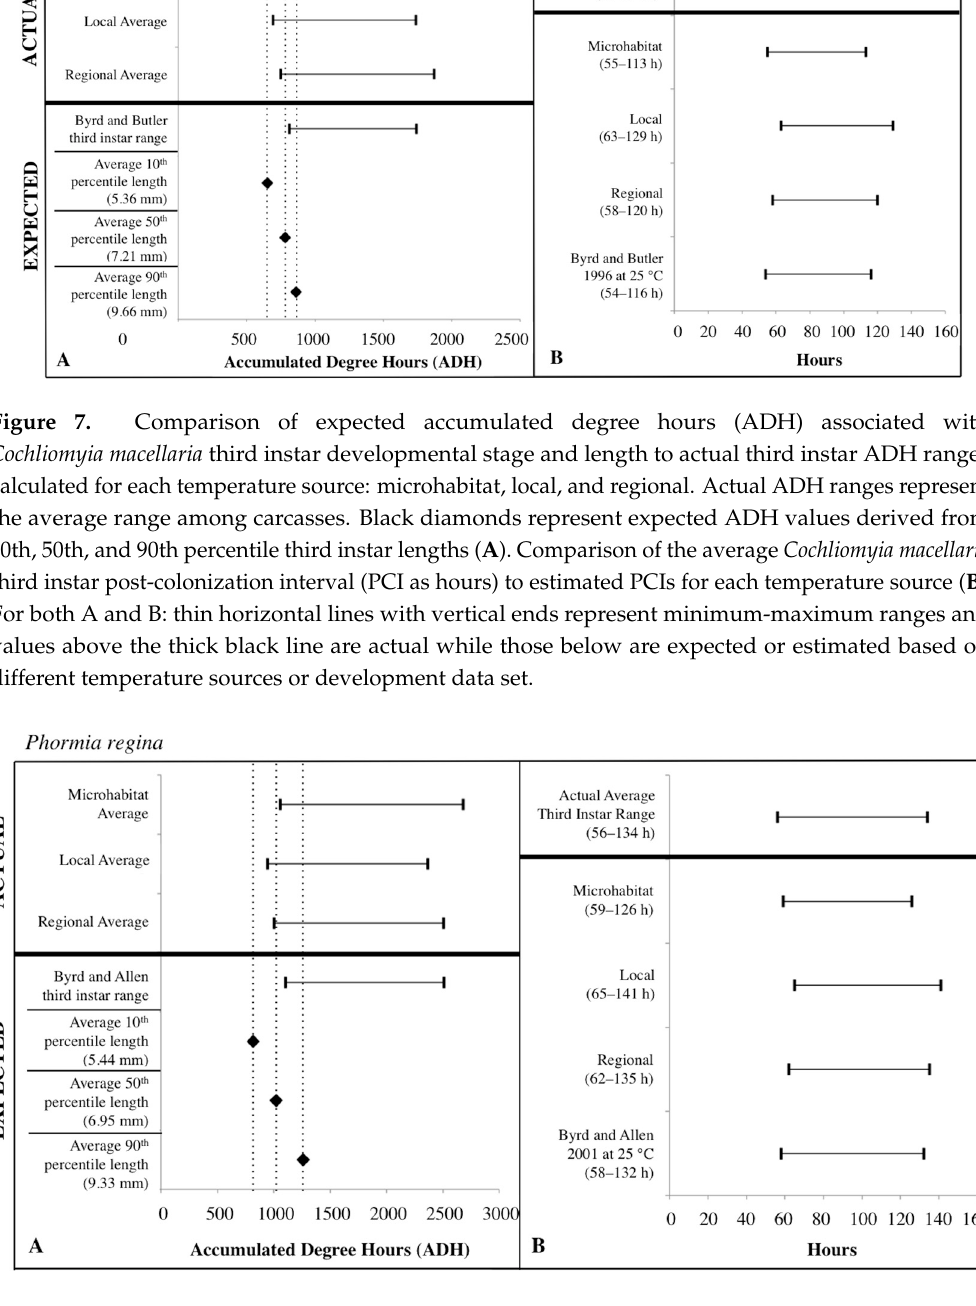
Figure 8. Comparison of expected accumulated degree hours (ADH) associated with Phormia regina third instar developmental stage and length to actual third instar ADH ranges calculated for each temperature source: microhabitat, local, and regional. Actual ADH ranges represent the average range among carcasses. Black diamonds represent expected ADH values derived from 10 th , 50 th , and 90 th percentile third instar lengths ( A ). Comparison of the average Phormia regina third instar post-colonization interval (PCI as hours) to estimated PCIs for each temperature source ( B ). For both A and B: thin horizontal lines with vertical ends represent minimum-maximum ranges and values above the thick black line are actual while those below are expected or estimated based on different temperature sources or development data set.